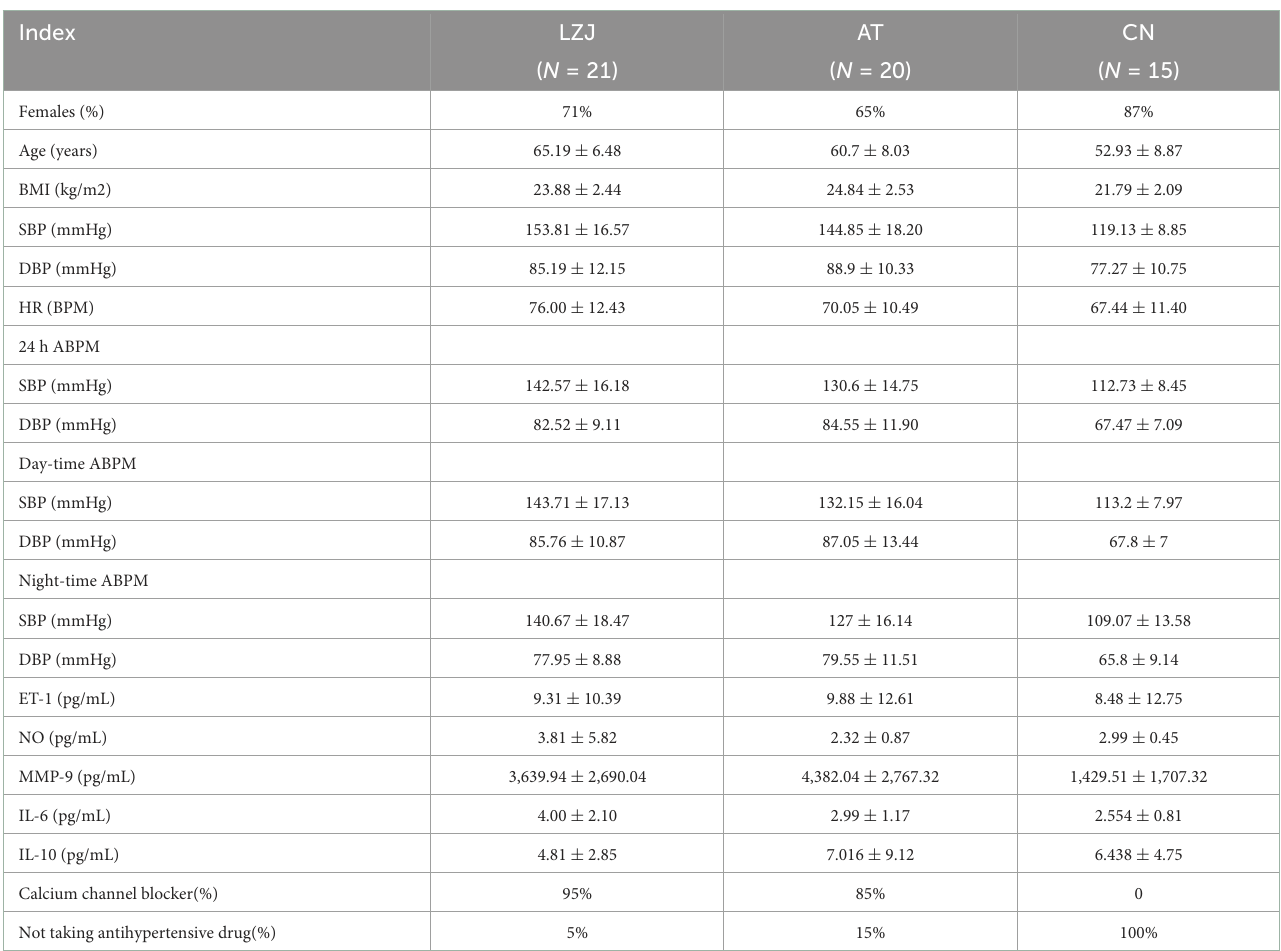
TABLE 1 Participant baseline